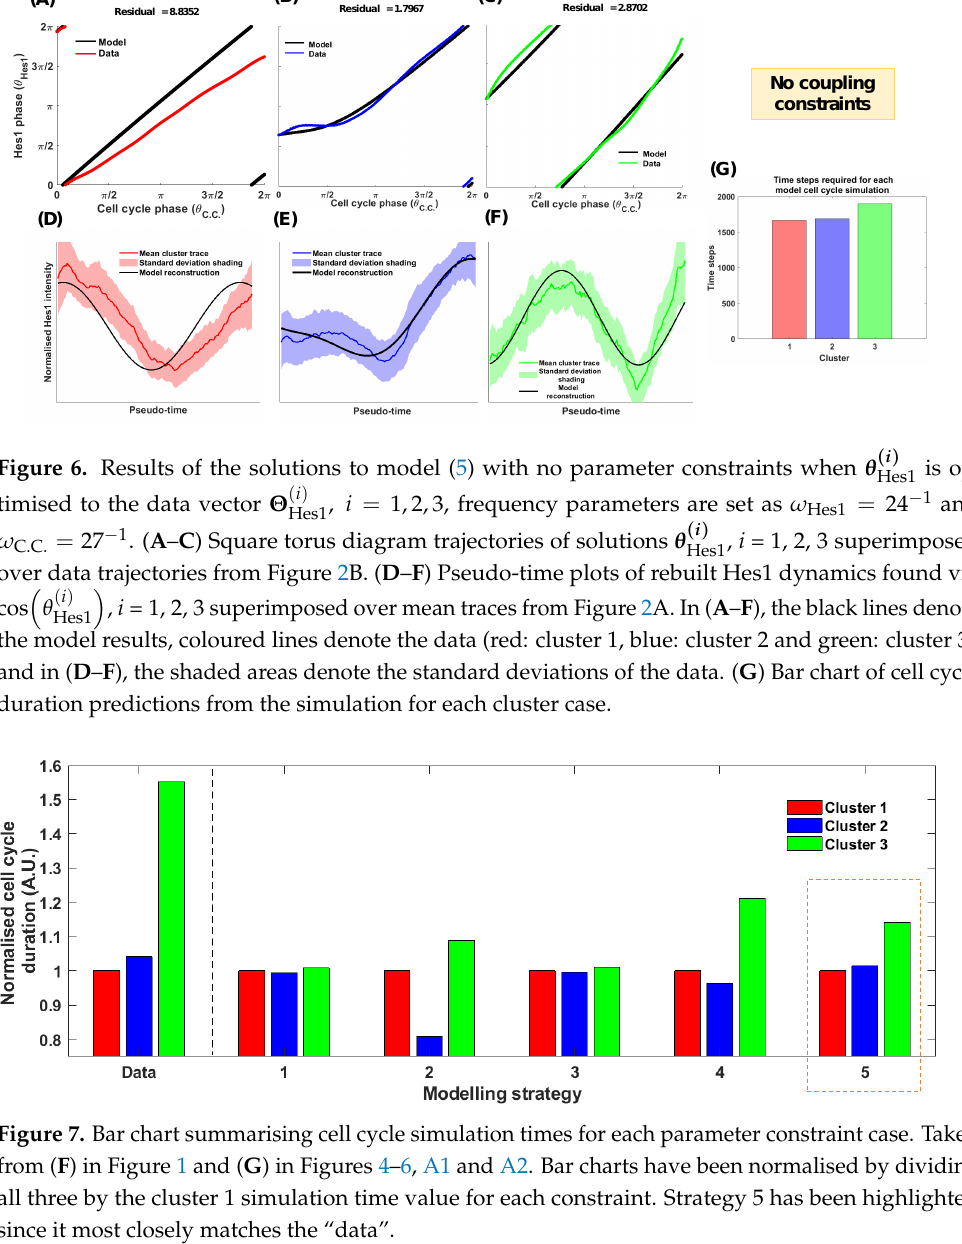
Figure 7. Bar chart summarising cell cycle simulation times for each parameter constraint case. Taken from ( F ) in Figure 1 and ( G ) in Figures 4–6, A1 and A2. Bar charts have been normalised by dividing all three by the cluster 1 simulation time value for each constraint. Strategy 5 has been highlighted since it most closely matches the